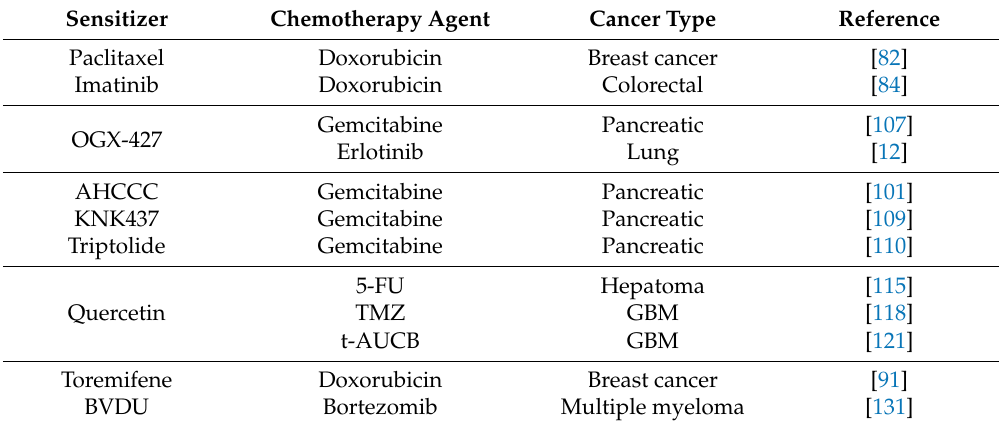
Table 1. Summary of Hsp27 modulators that can be utilized as potential chemotherapy